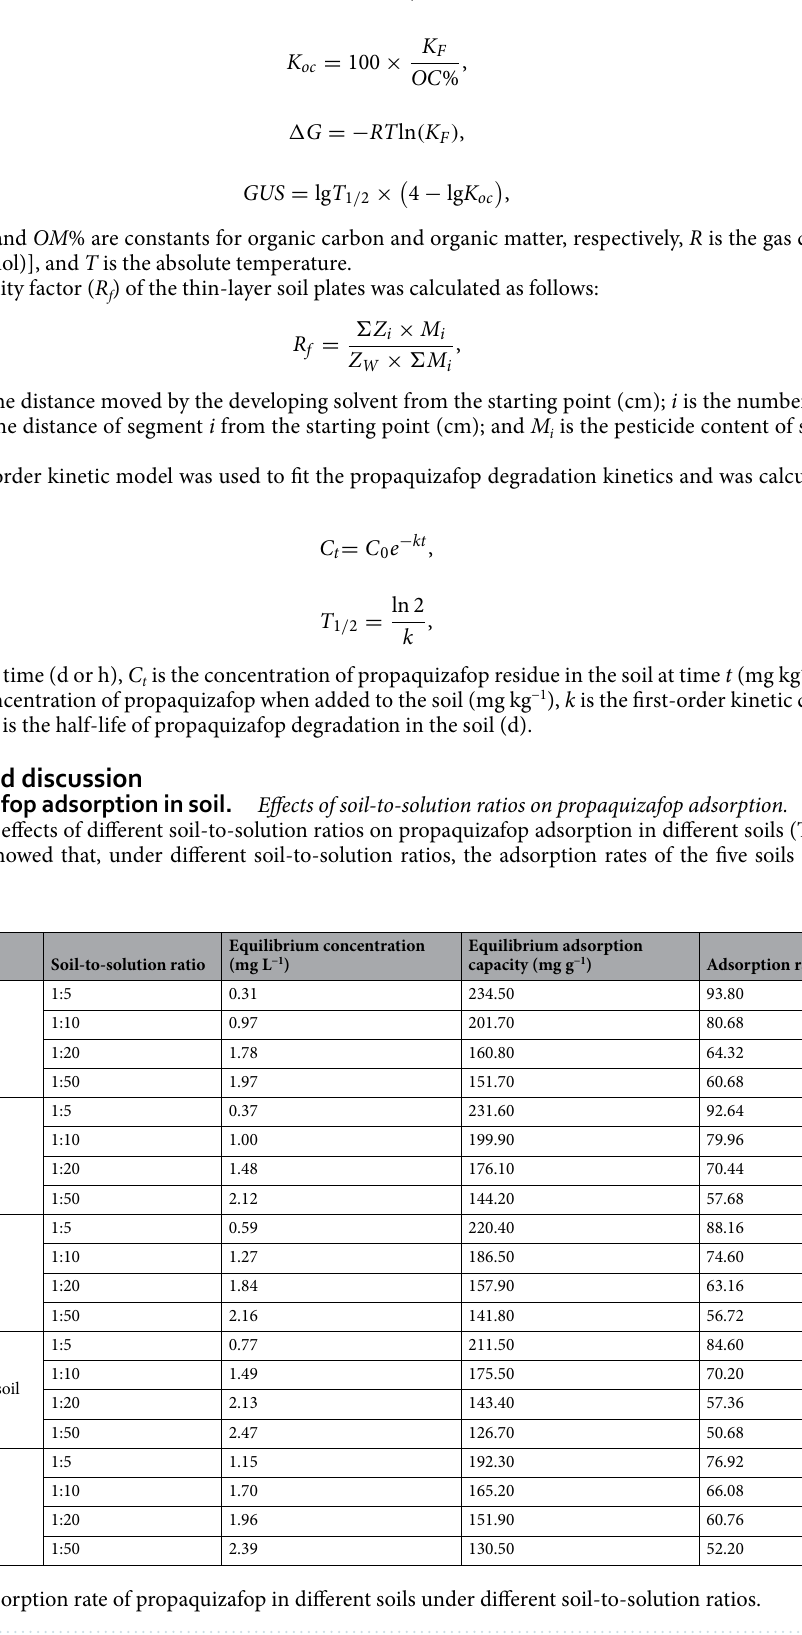
Table 2. Adsorption rate of propaquizafop in different soils under different soil-to-solution ratios.